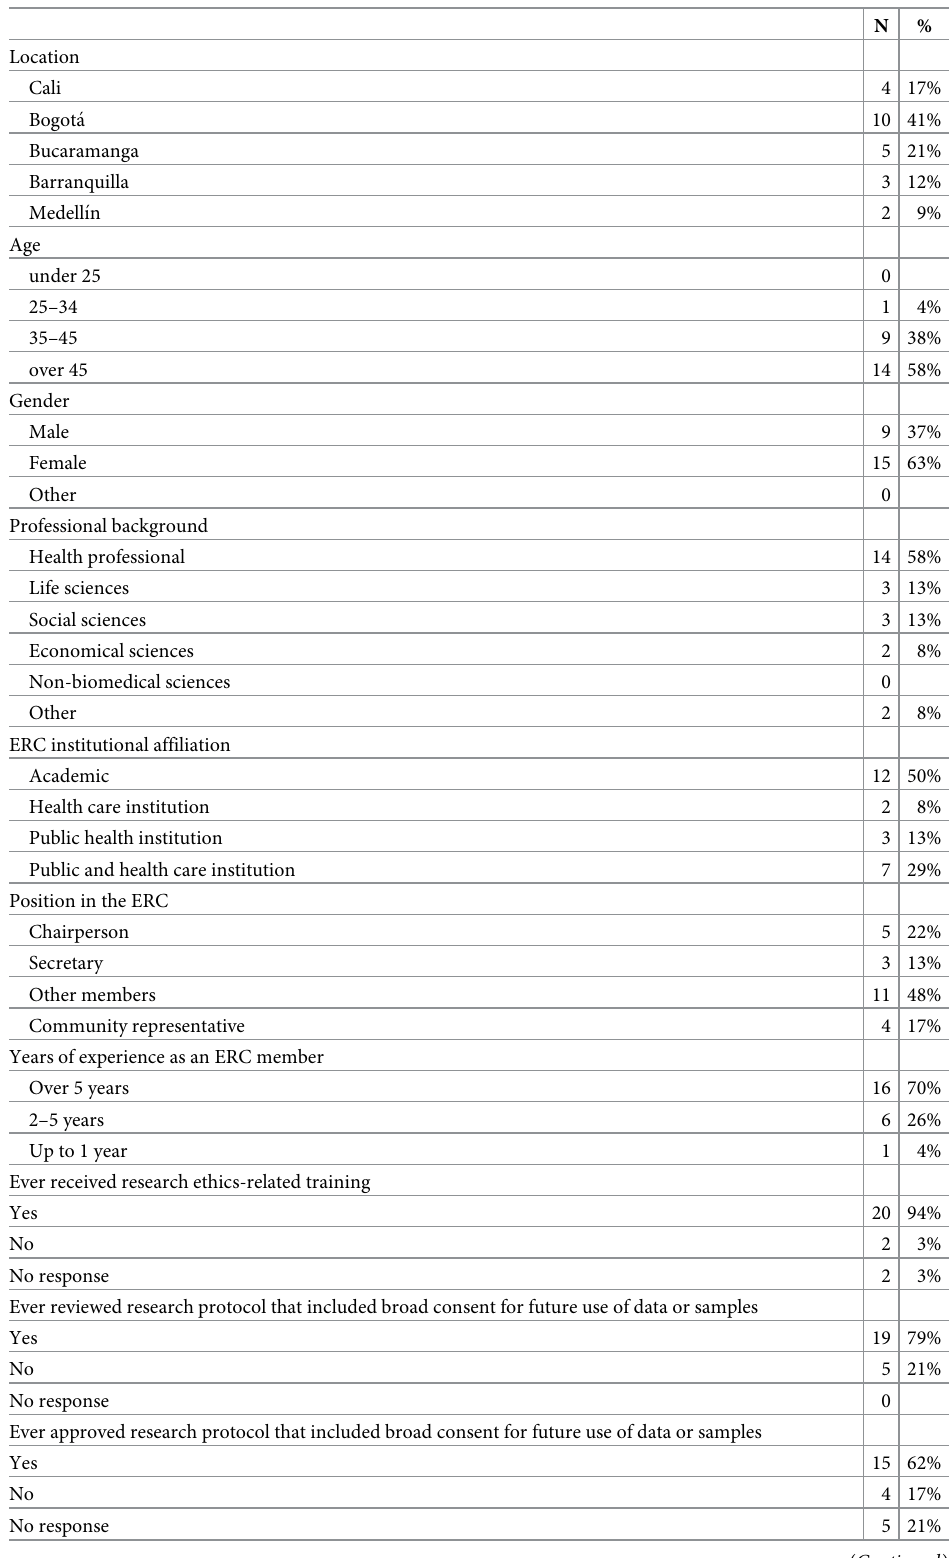
Table 1. Participant characteristics (N = 24).